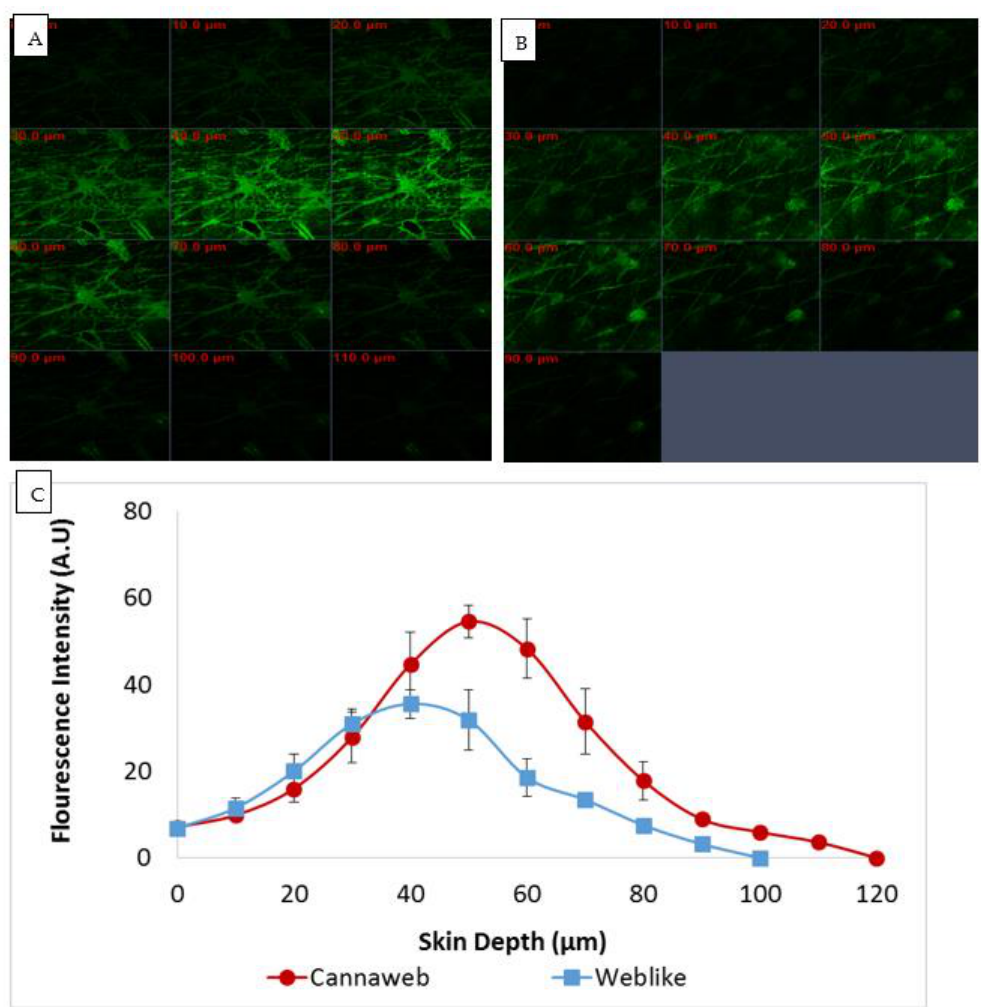
Figure 5. FITC delivery into the skin by CLSM: ( A ) Representative CLS micrographs of area skin sections at various depths treated with FITC in F7 (Cannaweb with HSO), ( B ) Representative CLS micrographs of area skin sections at various depths treated with FITC in F6 (Weblike without HSO), ( C ) Mean fluorescence intensity (AU) measured at various skin depths following application of Cannaweb with HSO vs. Weblike without HSO ( n = 4), Mean ± SEM. p < 0.05 (considered significant) at 50 – 70 µm and 100 µm, p < 0.01 (considered very significant) at 80 and 90 µm, by One-Way ANOVA.